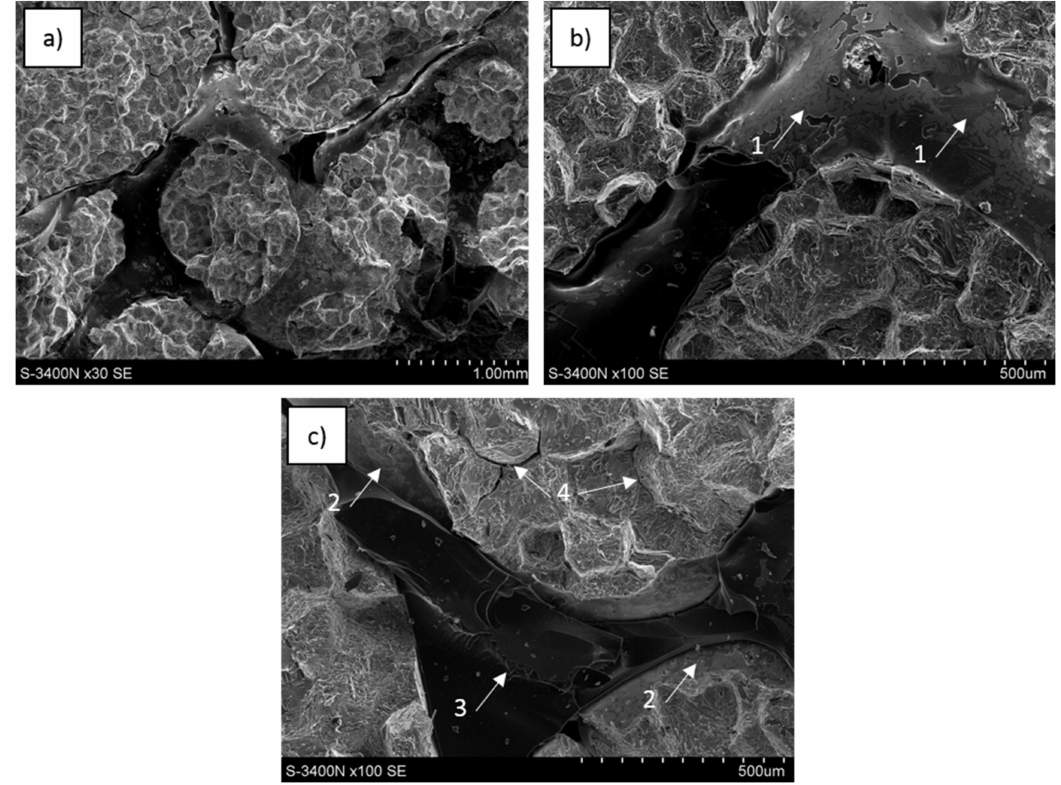
Figure 17. SEM images of C of 20ppi–RZ5 composite fractured during three-point bending strength testing: ( a ) metal cells surrounded with a fractured glassy carbon network, ( b ) surface of the carbon foam and matrix after delamination, thin layer of fine phases on C of surface (1), ( c ) fine phases on a delaminated matrix (2), C of cracked surface (3) and intergranular cracks in the metal matrix